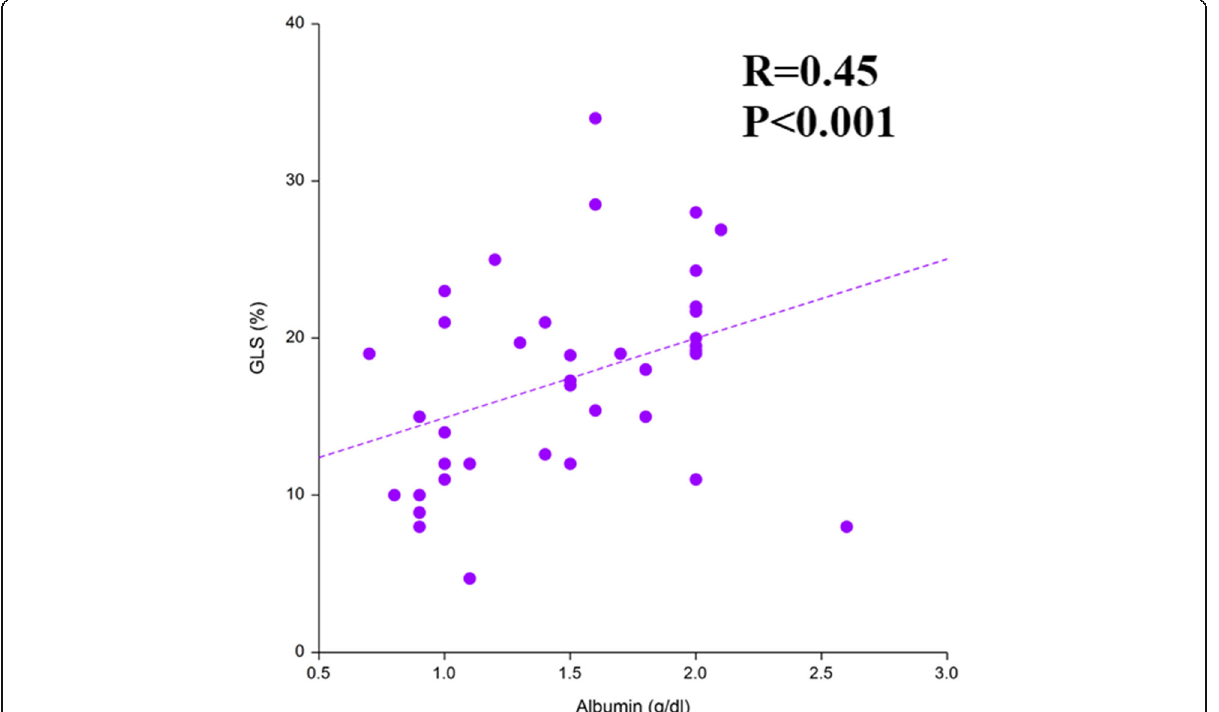
Fig. 1 Scatter plot showing relationship between LV GLS and serum albumin. Abbreviations: LV, left ventricular; GLS, global longitudinal strain